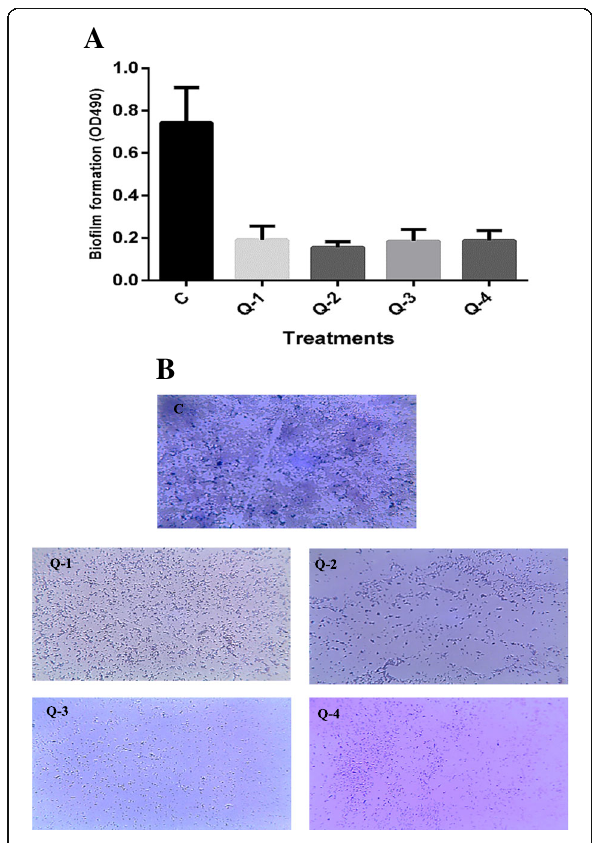
Fig. 3 a Quantitative measurement of biofilm inhibition in P. aeruginosa by crystal violet staining and measuring absorbance at 490 nm. Data are presented as mean ± SE. b Crystal violet stained light microscopic images of bacterial biofilms grown in the absence and presence of SICs of Q. infectoria gall extracts. c untreated, Q-1: ethyl acetate, Q-2: n-butanol, Q-3: ethanol, Q-4: aqueous